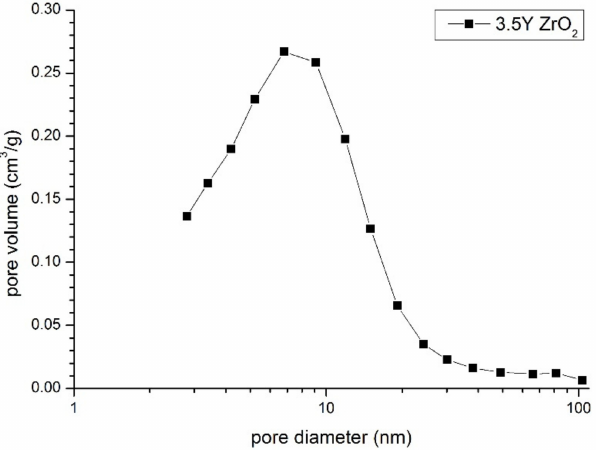
Figure 4. Pore size distribution curve of the powder compact of the powder